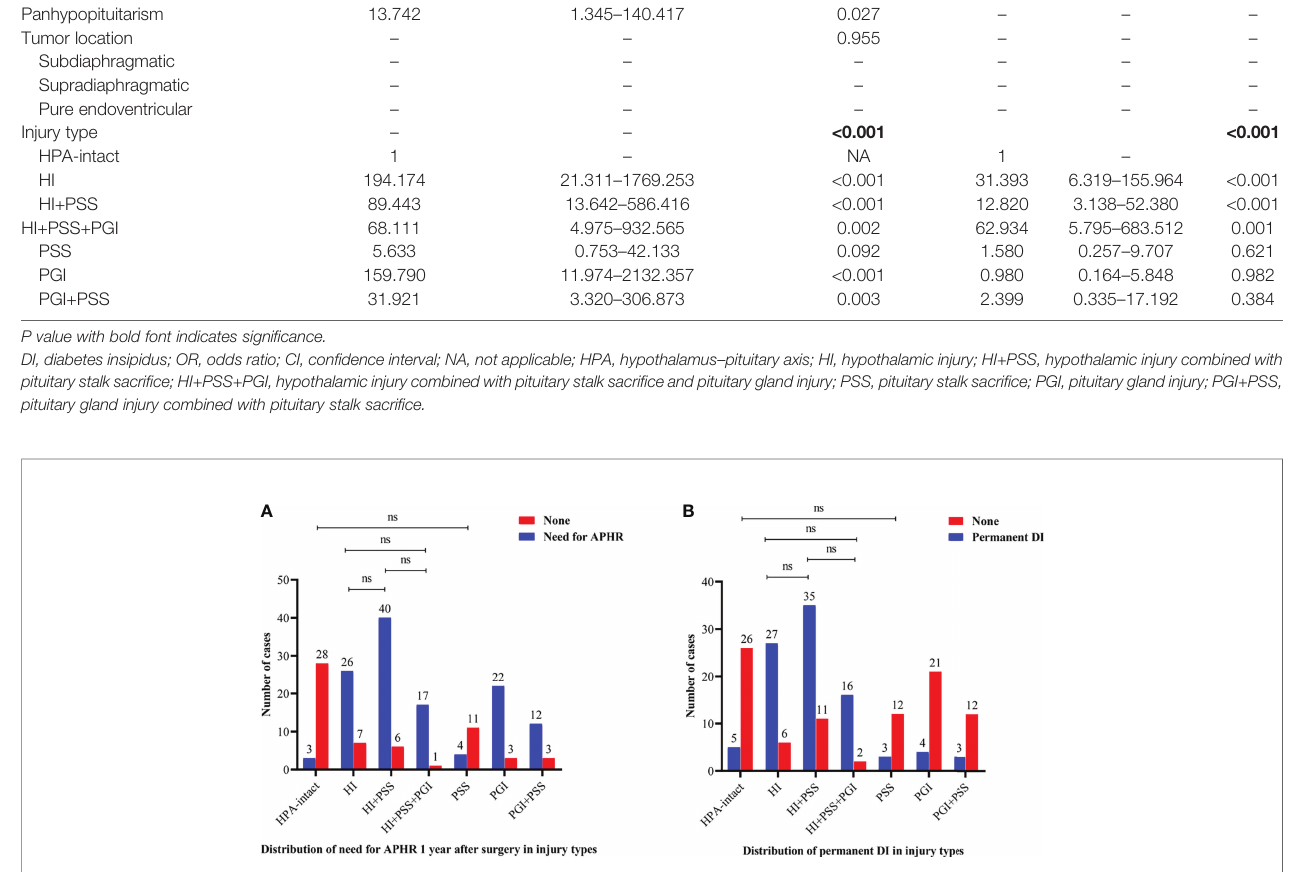
FIGURE 2 | Bar charts showing the distributions of need for anterior pituitary hormone replacement 1 year after surgery (A) and permanent DI (B) between injury types in the entire cohort. HPA, hypothalamus – pituitary axis; PSS, pituitary stalk sacri fi ce; PGI+PSS, pituitary gland injury combined with pituitary stalk sacri fi ce; HI +PSS+PGI, hypothalamic injury combined with pituitary stalk sacri fi ce and pituitary gland injury; HI+PSS, hypothalamic injury combined with pituitary stalk sacri fi ce; PGI, pituitary gland injury; HI, hypothalamic injury; APHR, anterior pituitary hormone replacement; DI, diabetes insipidus; ns, not signi fi